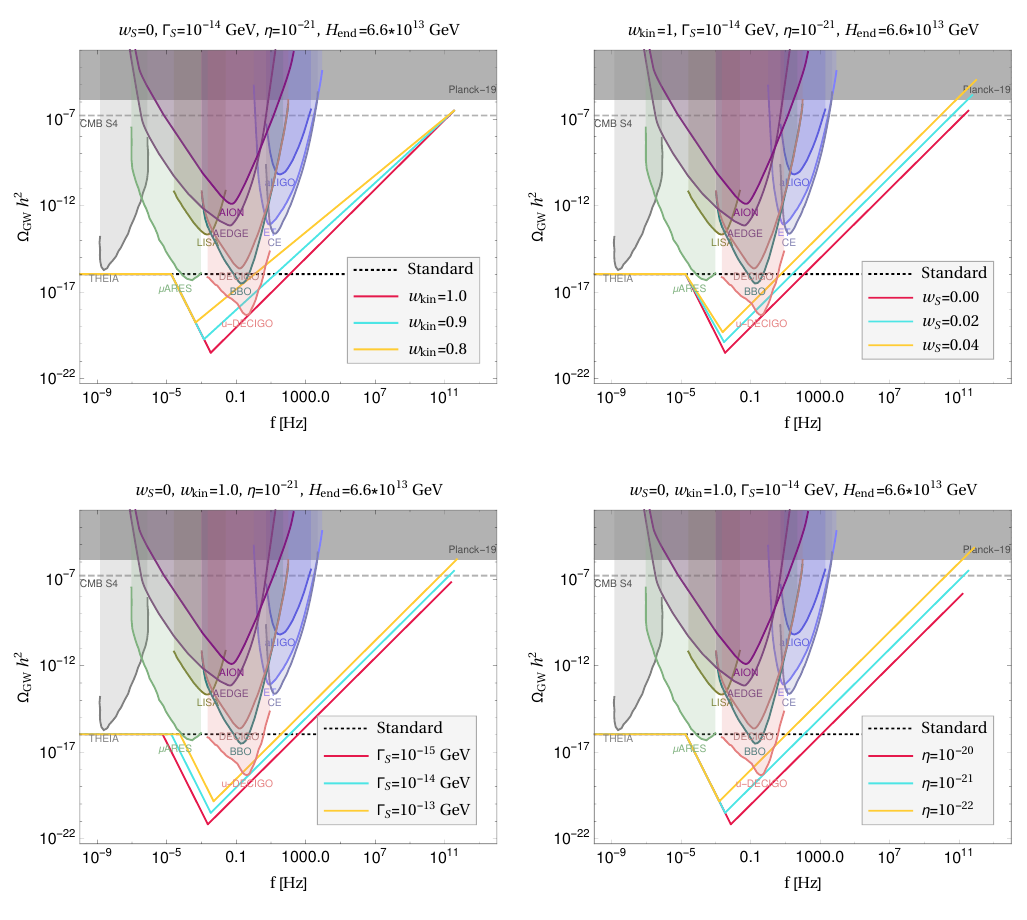
Figure 2 . Dependence of GW spectrum with variation of different parameters, w k , w S , Γ S , η respectively, keeping the other parameters